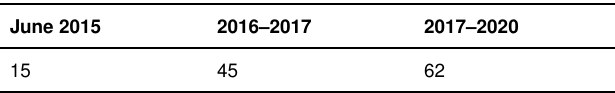
Table 1. PEN membership development in numbers from